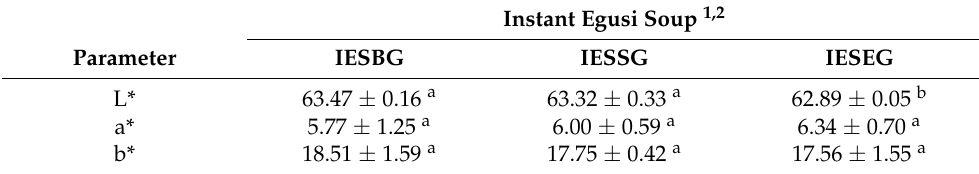
Table 5. Colour of instant egusi soup.